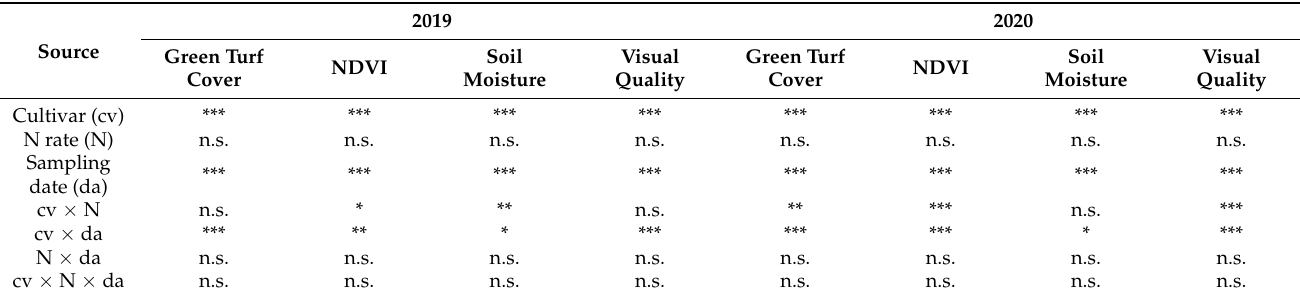
Table 1. Results of the analysis of variance testing the effects of the cultivar and sampling date and their interaction on the percentage of green turf cover, the normalised difference vegetation index (NDVI), soil moisture, visual quality (scale 1–9) and colour (scale 1–9).